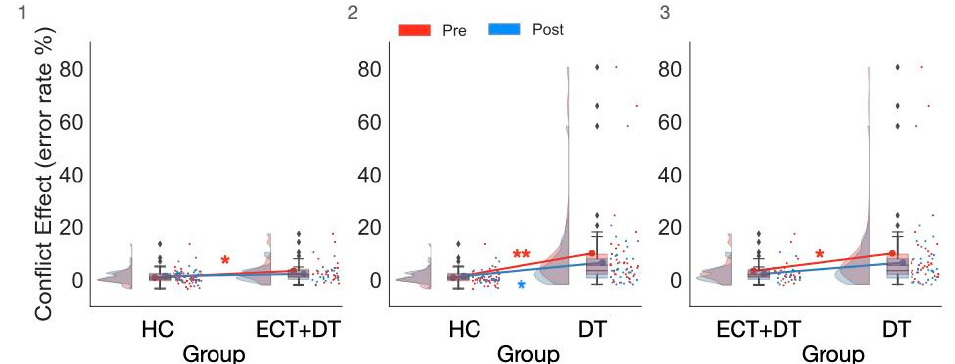
Figure 4 . The significant Group × Conflict interaction observed in the Bayesian ANOVA on error rate showed that both the ECT + DT and DT groups made significantly more errors compared with the HC group at pretest, while this difference was significant at post-test only in the DT group. ( 1 ) Comparison between the HC and ECT + DT groups, ( 2 ) comparison between the HC and DT groups, ( 3 ) comparison between the ECT + DT and DT groups. * p < 0.01, ** p < 0.001. ♦ indicates outlier.